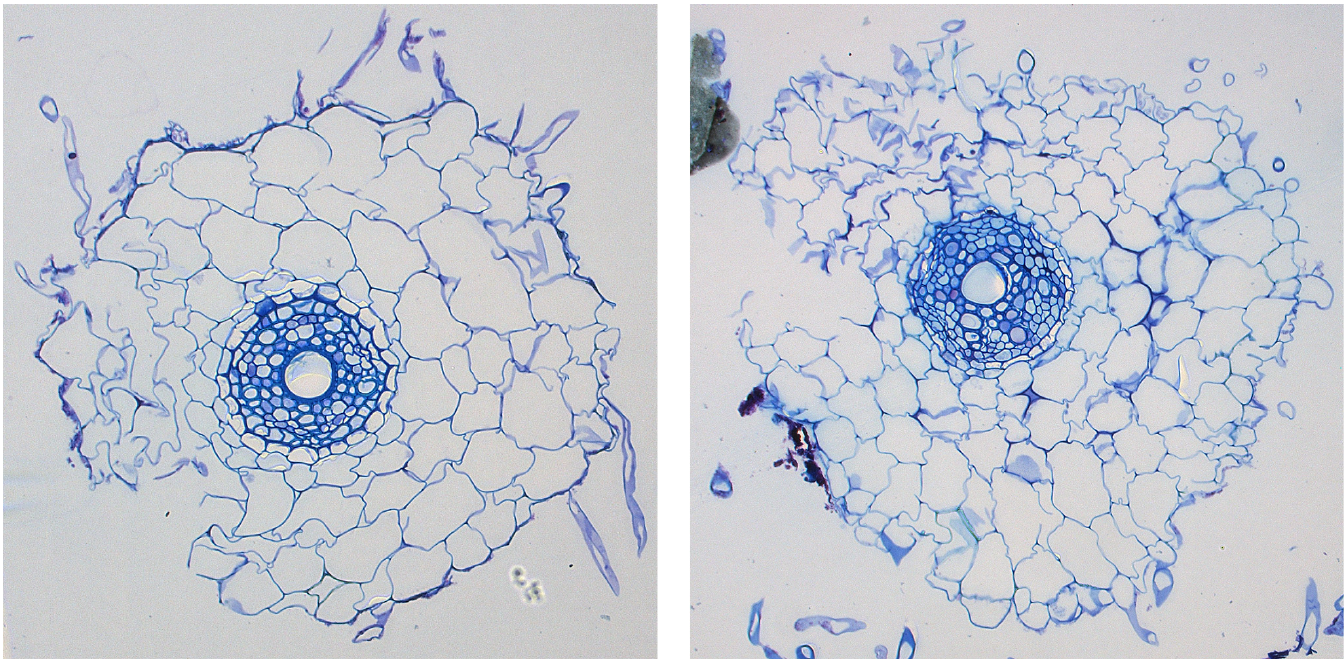
Fig 11. Two images from the set of 15 showing damaged roots. The two images depict damaged root cross-sections with missing or displaced epidermis and cortex regions. The damaged sections are major factors contributing to the relatively large errors in cortex (and presumably epidermis) cell calculations.